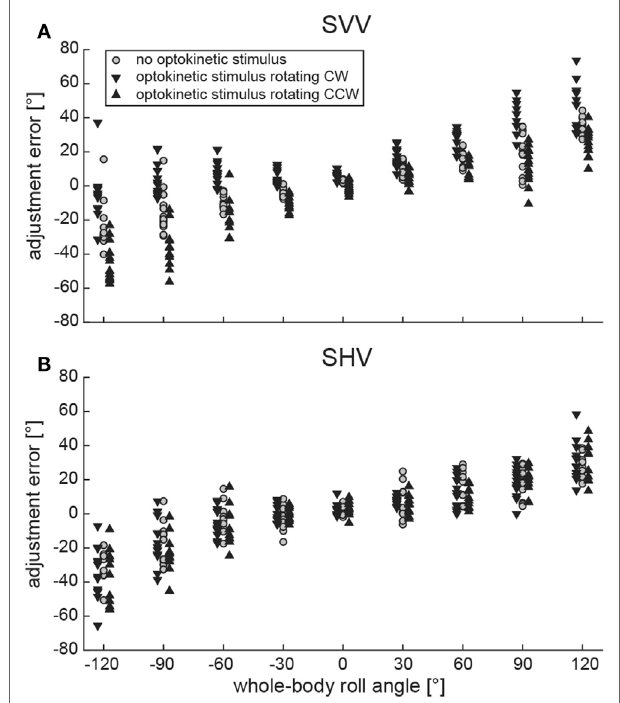
FigUre 2 | Single adjustments in a representative subject (#10) are plotted against whole-body roll position (roll-tilt up to ± 120°, steps of 30°) for both the SVV paradigm (a) and the subjective haptic vertical (SHV) paradigm (B) . Trials from the three different conditions (gray circles = baseline; inverted black triangles = optokinetic stimulus rotating CW; black triangles = optokinetic stimulus rotating CCW) are shown separately and were slightly displaced laterally for better